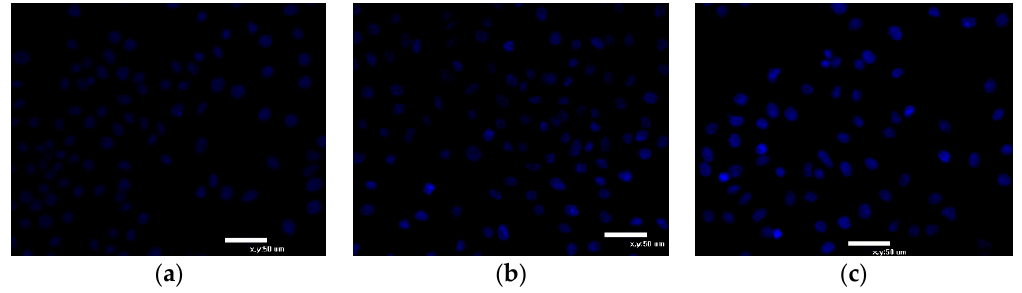
Figure 9. Effect of EPS-3a induced HepG2 cells apoptosis by Hoechst 33342 staining. Cells were treated with EPS-3a for different time (24 h, 48 h and 72 h). The concentration of EPS-3a was 313.75 μ g/mL. ( a ) Control, 0 h. ( b ) Cells treated with EPS-3a for 24 h. ( c ) Cells treated with EPS-3a for 48 h.